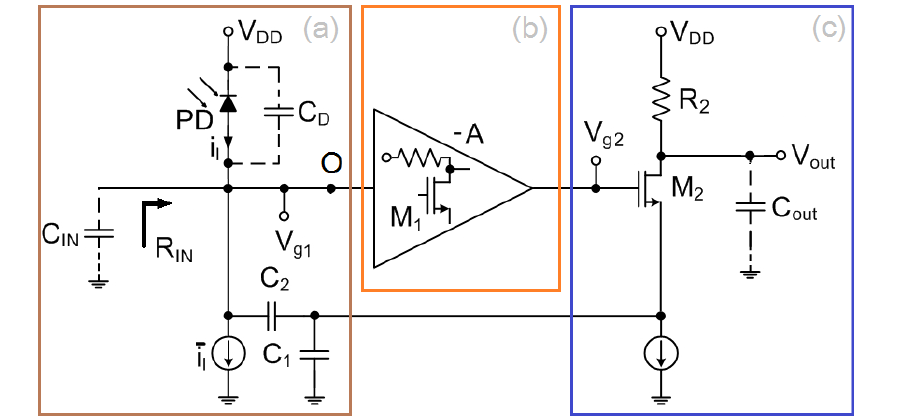
Figure 1. The general structure of the proposed capacitive feedback TIA with major blocks: ( a ) feed- back block, ( b ) forward-gain block; ( c ) source-follower block (adopted with changes from